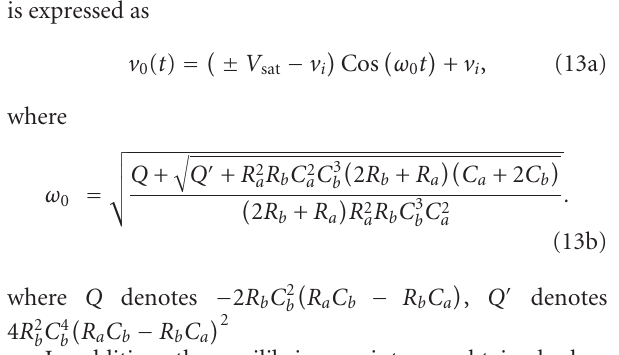
Figure 2: The twin-T